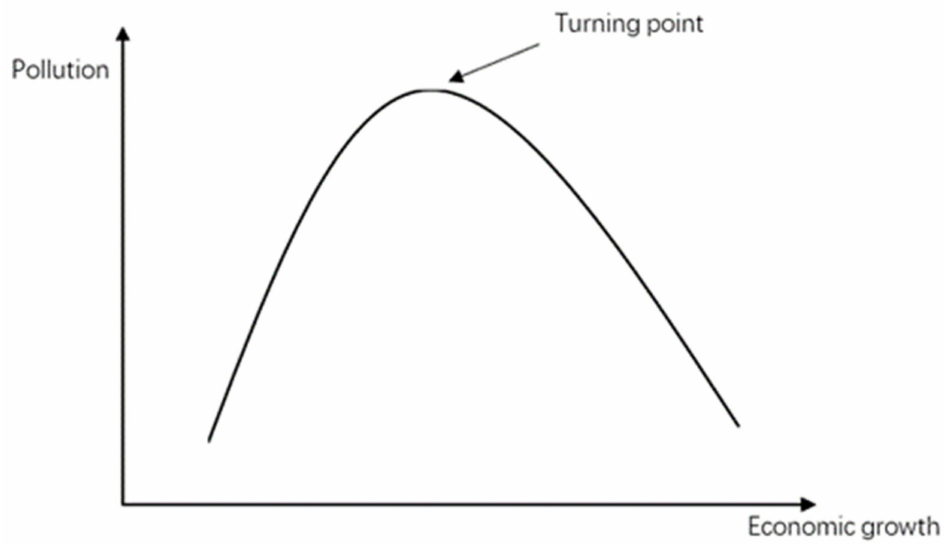
Figure 1. Environmental Kuznets curve